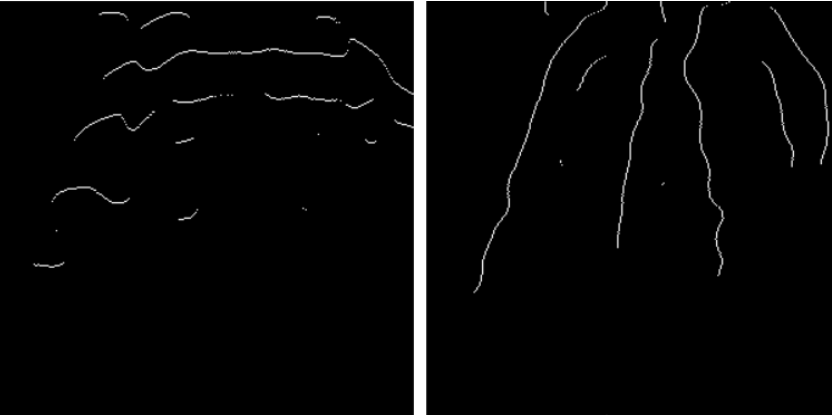
Figure 5. Candidate lines generated by connecting local maxima obtained through ( left ) vertical search, ( right ) horizontal search.